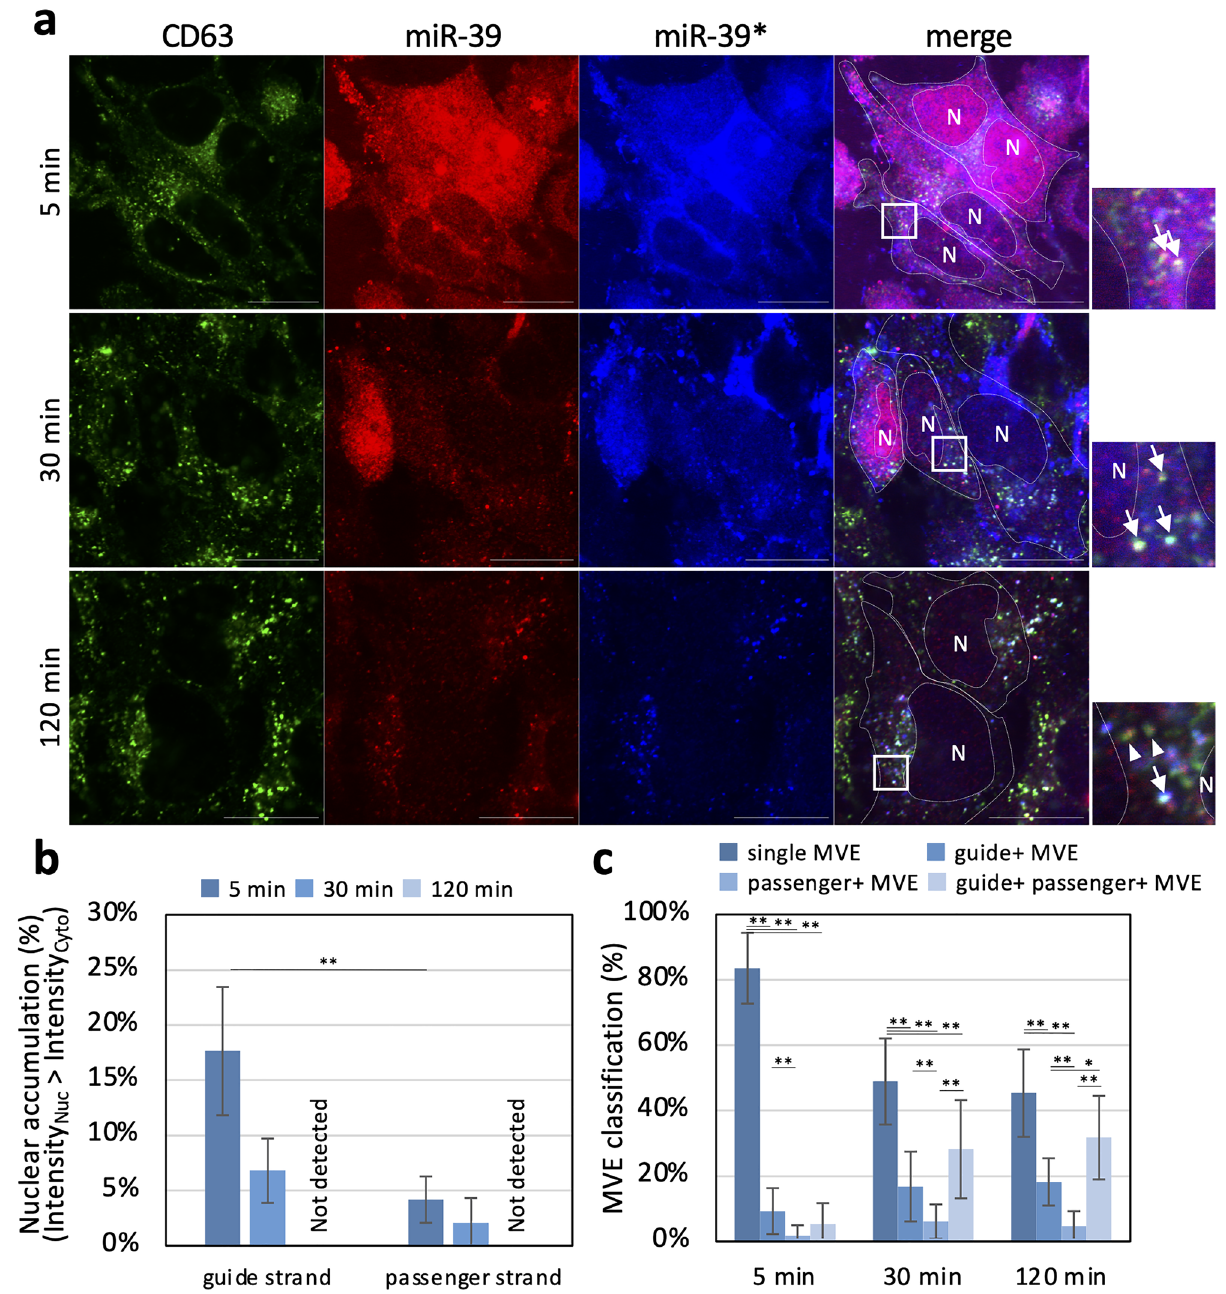
Figure 3. Time-dependent localization changes of exogenously added fluorescent-labeled strands of miRNA introduced into resealed HeLa cells. ( a ) Fluorescence microscopy images of the miRNA introduced in resealed HeLa cells. After introducing cytosol containing a 1.5 µM fluorescently labeled miRNA mimic, resealed HeLa cells were fixed at 5, 30, and 120 min after resealing and subjected to IF analysis using anti-CD63 antibody. Fluorescence signals of guide (miR-39) strands, passenger (miR-39*) strands, and CD63-positive MVEs were observed by confocal microscopy. Arrows indicate CD63-positive MVEs co-localized with both guide and passenger strands. Arrowheads indicate CD63-positive MVEs co-localized with the guide strand but not with the passenger strand. White dotted lines outline the cell and nucleus. Nuclear regions are indicated as “N” inside the dotted line. Scale bar = 20 µm. ( b ) Bar plots show the population ratio of cells in which miRNAs were accumulated in the nucleus. Data represent results from five frames (5 points and ~ 80 cells/sample; n = 5), expressed as the mean ± SD. * P < 0.05; ** P < 0.01. ( c ) Bar plots show the population ratio of MVEs classified by the miRNA co-localization manner. For counting, we processed images using Laplacian of Gaussian (LoG) filtering to remove noise. Observed MVEs were selected at random (20 points/cell) and classified by co-localized miRNA bright spots. Data represent results from 14 cells ( n = 14), expressed as the mean ± SD. * P < 0.05; ** P < 0.01. single, no co-localized; guide + , co-localized with guide strand, passenger + MVE, co-localized with passenger